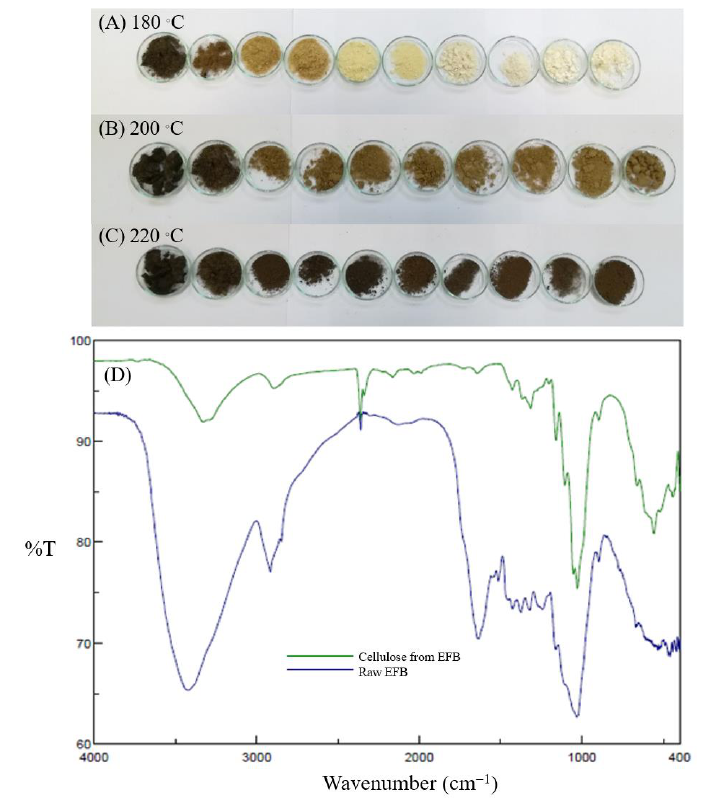
Figure 2. Cellulose bleaching of pretreated EFB at different hydrothermal temperatures ( A ) 180 °C, ( B ) 200 °C, ( C ) 220 °C using 30 wt% H 2 O 2 solution at 60 °C for ten times; and ( D ) FTIR graph represent between purified cellulose from EFB using hydrothermal fractionation at 180 °C for 1 h and bleached with 30wt% H 2 O 2 for seven times at 60 °C compared with raw EFB. FTIR spectra of purified cellulose from 180 °C, 3 MPa, 1 h plus 7th bleaching and raw EFB are shown in Figure 2B. The peak intensity of purified cellulose from EFB was clearly seen at the wavenumber of 2400 cm − 1 which represented carboxylic functional group [30], while less intensity was found in raw EFB. The FTIR peaks at the wavenumber of 1515 cm − 1 , which represents a benzene ring of lignin [10], and at the wavenumber of 1240 cm − 1 , which represents the carbonyl bond of lignin can be found in EFB but not in the purified cellulose from EFB. This clearly revealed that lignin has been extracted out from the hy- drothermal fractionation and subsequent bleaching process due to the chemical oxidation reaction of hydrogen peroxide. It was reported that alkaline hydrogen peroxide dissoci- ates oxygen with free electrons and radicals [31] which interact with residual hemicellu- lose, lignin and chromophores [32]. This process reduces the chromophore molecular size, and additionally decomposes chromophore, thus led the cellulose color alteration to paler and brighter during bleaching. 2.2. CMC Synthesis from EFB Derived Cellulose Carboxymethyl cellulose was synthesized from purified cellulose from EFB as de- picted in Figure S1. Degree of substitution (DS) and whiteness of synthesized CMC from EFB derived cellulose at different CMC synthesis conditions (%NaOH, %monochloroace- tic acid and etherification temperature) were presented in Table S3. As shown in Scheme S1, the first step of CMC synthesis is cellulose mercerization or alkalization in NaOH so- lution. In this step, cellulose is protonated at the CH 2 OH functional group, and subse- quently substituted by Na + from NaOH to form CH 2 ONa functional group. The position